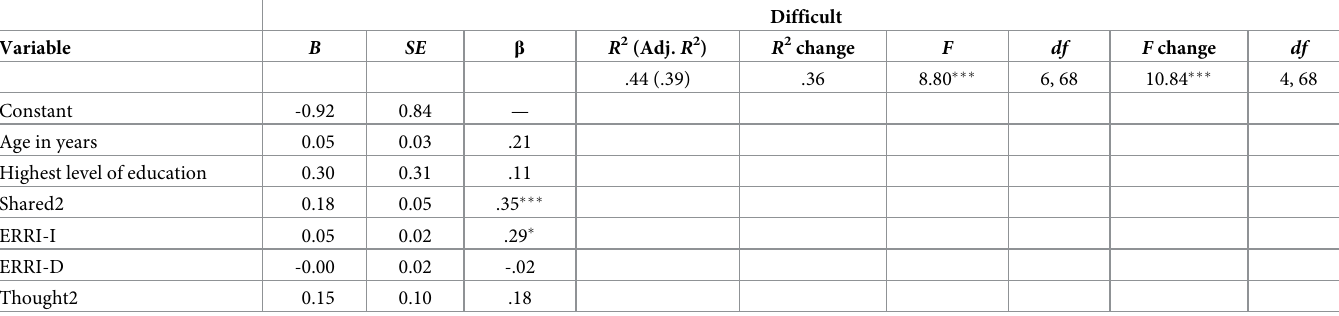
Table 5. Final hierarchical multiple linear regression model on identity fusion with mothers who have had a very difficult